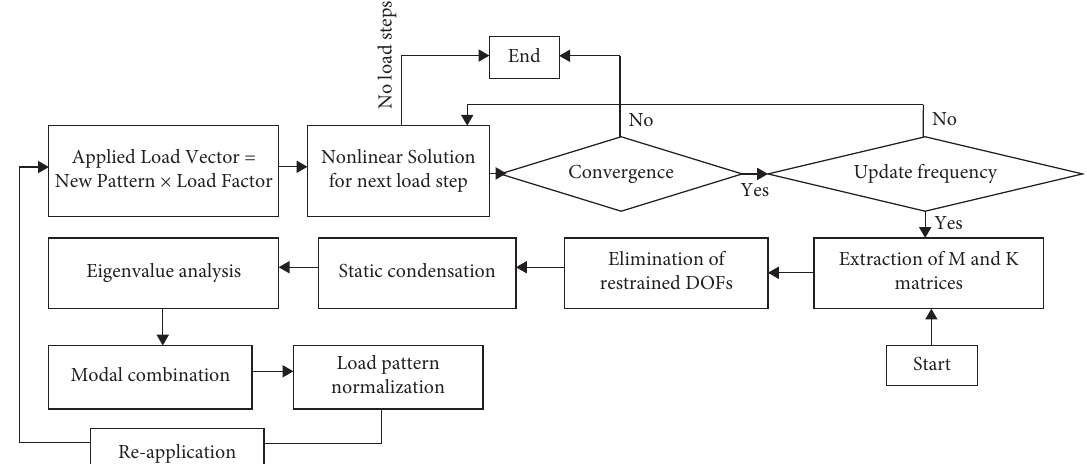
Figure 1: Flowchart of an adaptive pushover analysis.